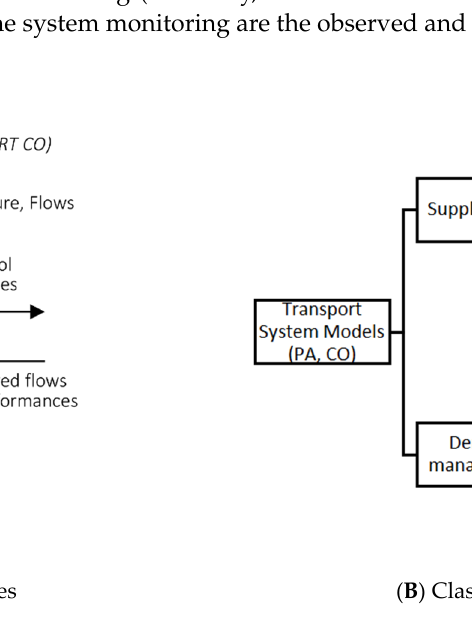
Figure 4. MaaS Transportation System Model platform (level 2, Intelligent MaaS).